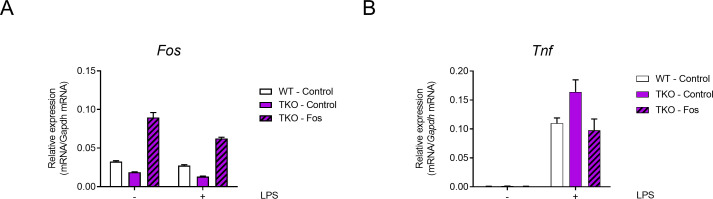
Overexpression of Fos reduces the expression of TNF in TKO BMDMs.(A and B) qPCR analysis of Fos (A) and Tnf (B) mRNA in WT and TKO BMDMs transfected with control or Fos overexpression vector and stimulated with or without LPS for 6 hr. Data are representative of three independent experiments (mean + s.d.).